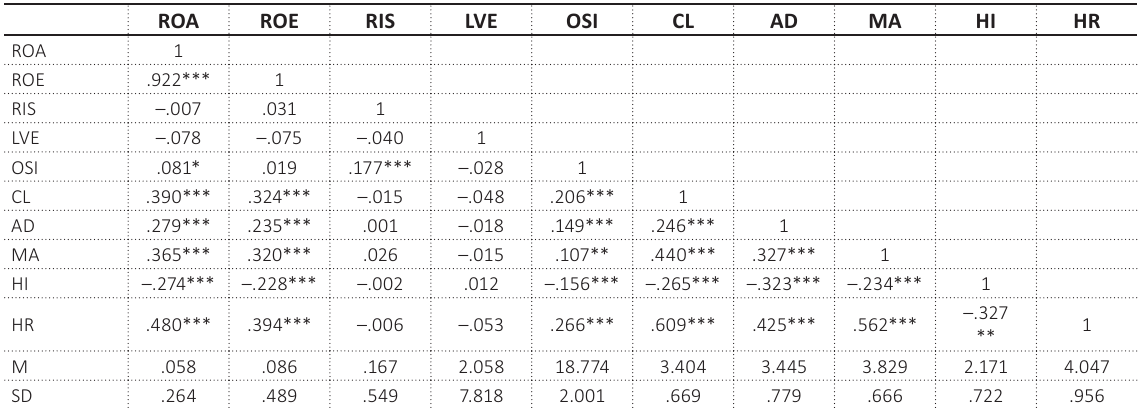
Table 3. Correlations, mean and standard